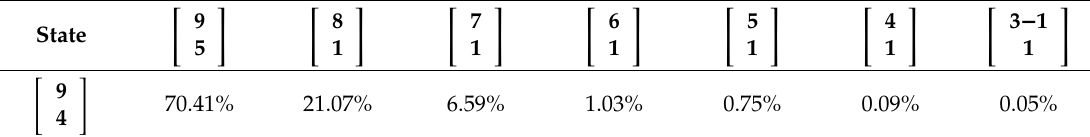
(cid:3431). (cid:2872)